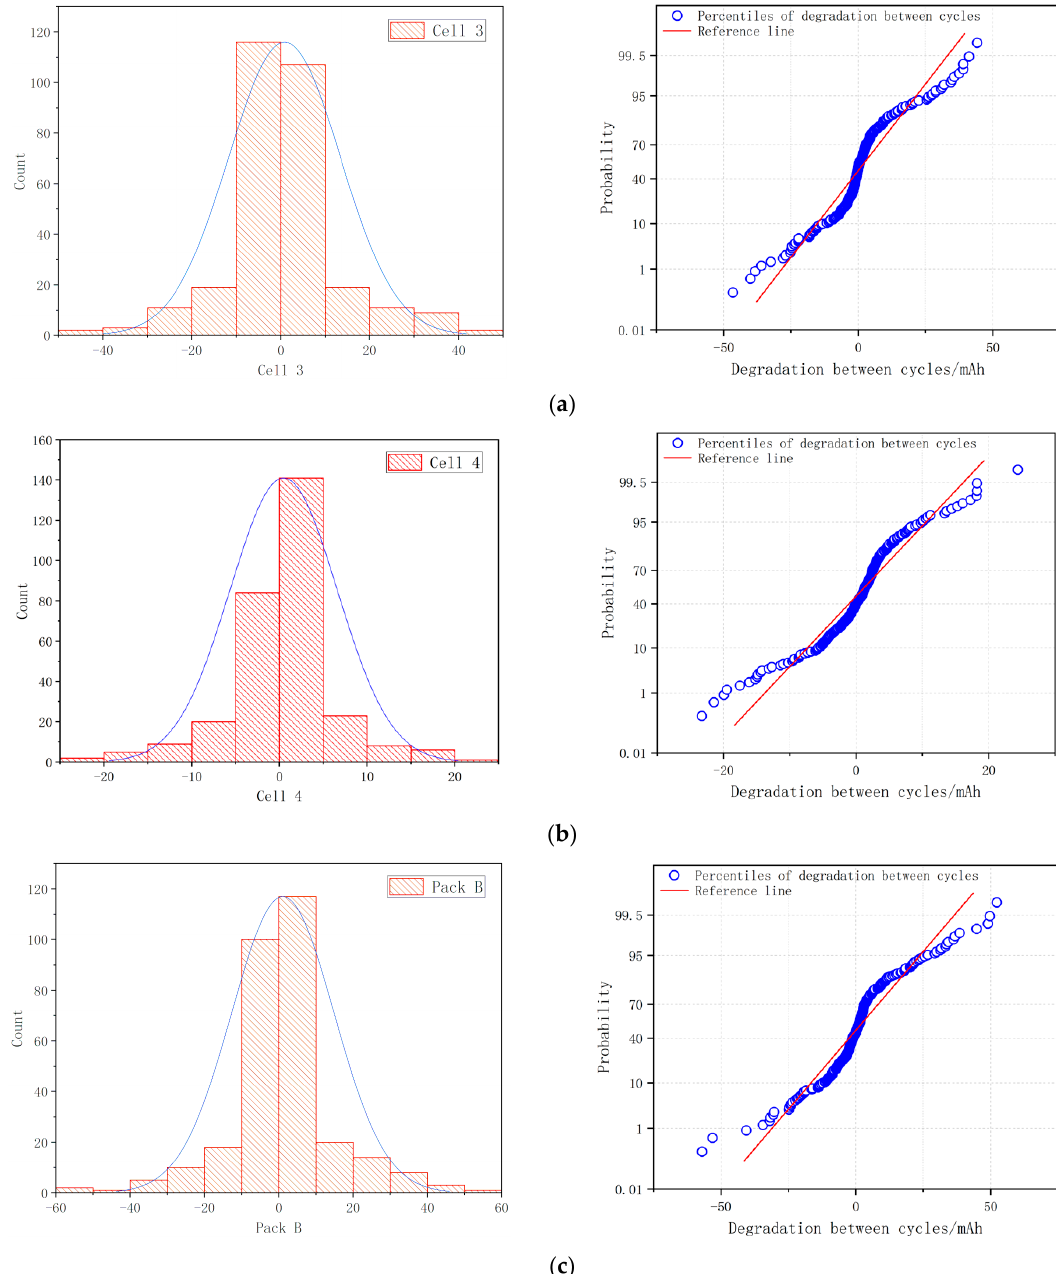
Figure A1. Probability map of capacity degradations between cycles: ( a ) Cell-3; ( b ) Cell-4; ( c ) Pack B.